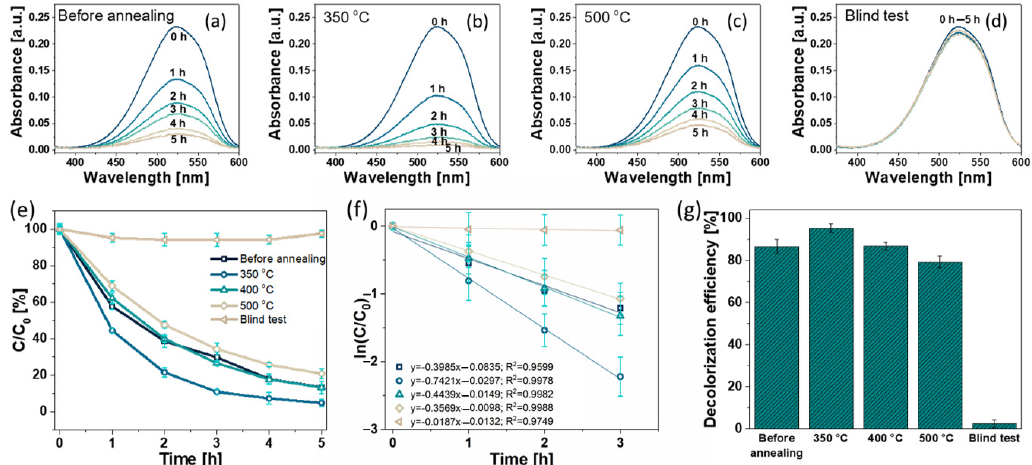
Figure 7. Time-dependent UV-Vis absorption spectra of MR solutions illuminated in the presence of as-synthesized ( a ), annealed at 350 ◦ C ( b ) and 500 ◦ C ( c ) ZrO 2 samples or in the absence of the photocatalyst ( d ). The corresponding C/C 0 vs. time curves for the wavelength of maximum absorbance of 524 nm for all tested samples ( e ). Corresponding pseudo first-order kinetic reaction plots ( f ). Photocatalytic decolorization efficiency of MR solutions ( g